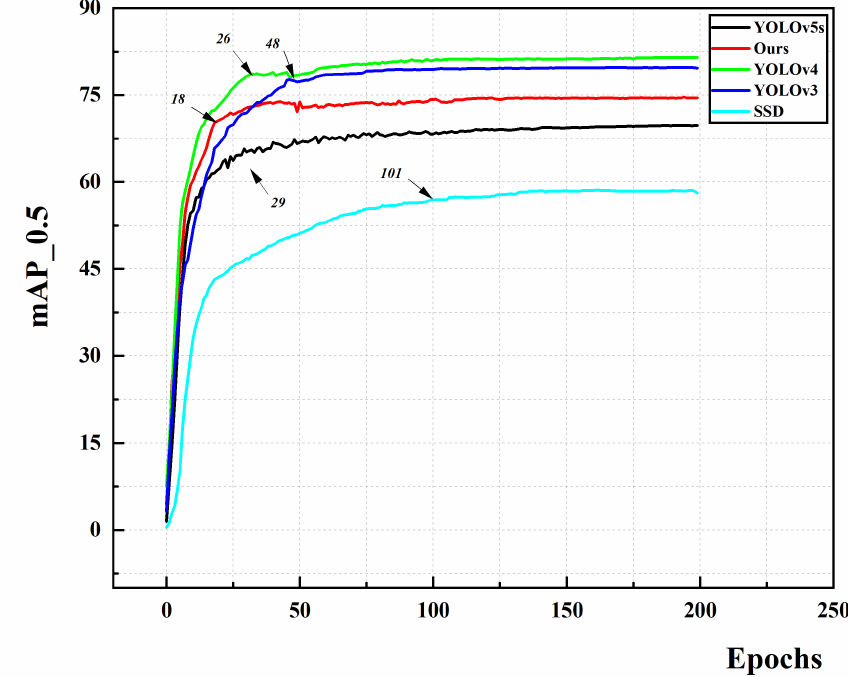
Figure 10. The mAP map of each model evolves with the training